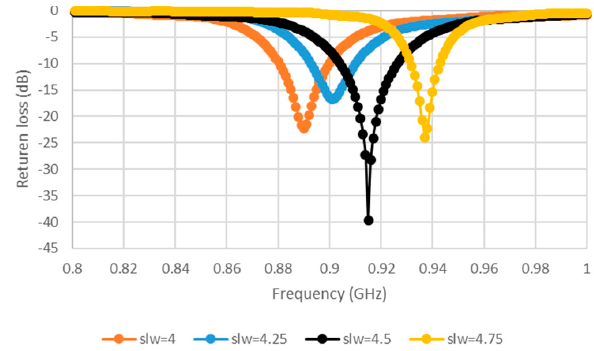
Figure 3. Simulated return losses (S11) for various slot widths (slw).